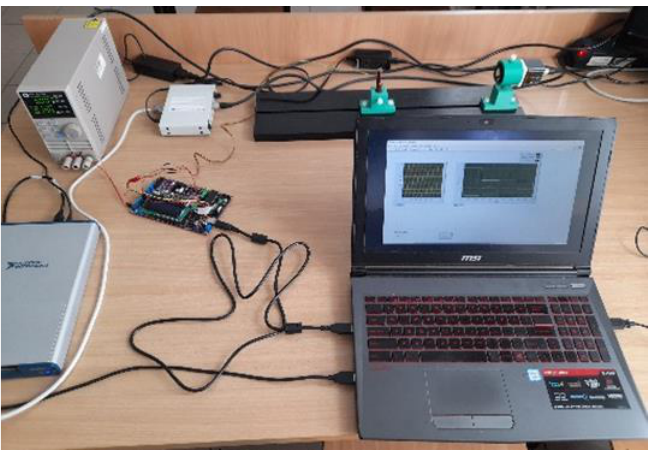
Figure 3. Image of the laboratory stand.